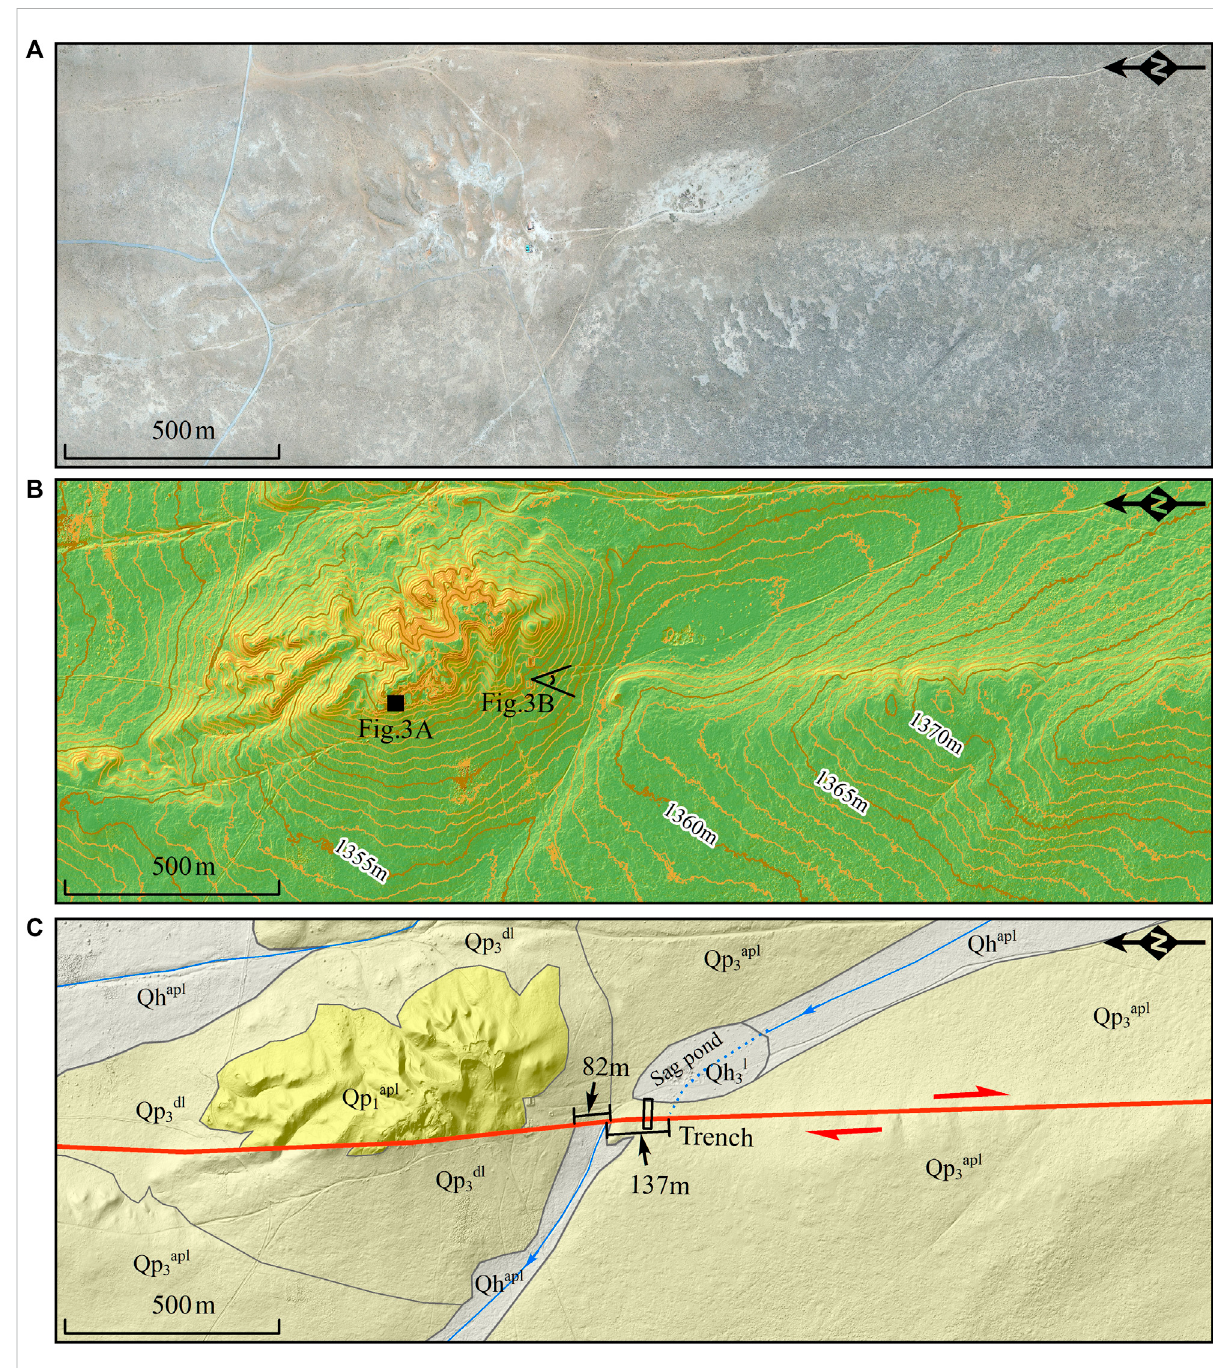
FIGURE 2 SitesouthofSumutu. (A) DOMin5 cmresolution. (B) ShadedrelieffromDEMin10cmresolution.withcontours. (C) OffsetGeologicalmapand offset landforms. Qh 3 l : active sag pond sediment; Qh apl : Holocene alluvial; Qp 3 apl : Late Pleistocene alluvial; Qp 3 dl : Late Pleistocene deluvial; Qp 1 apl : Early Pleistocene alluvial; Rectangle denotes the trench